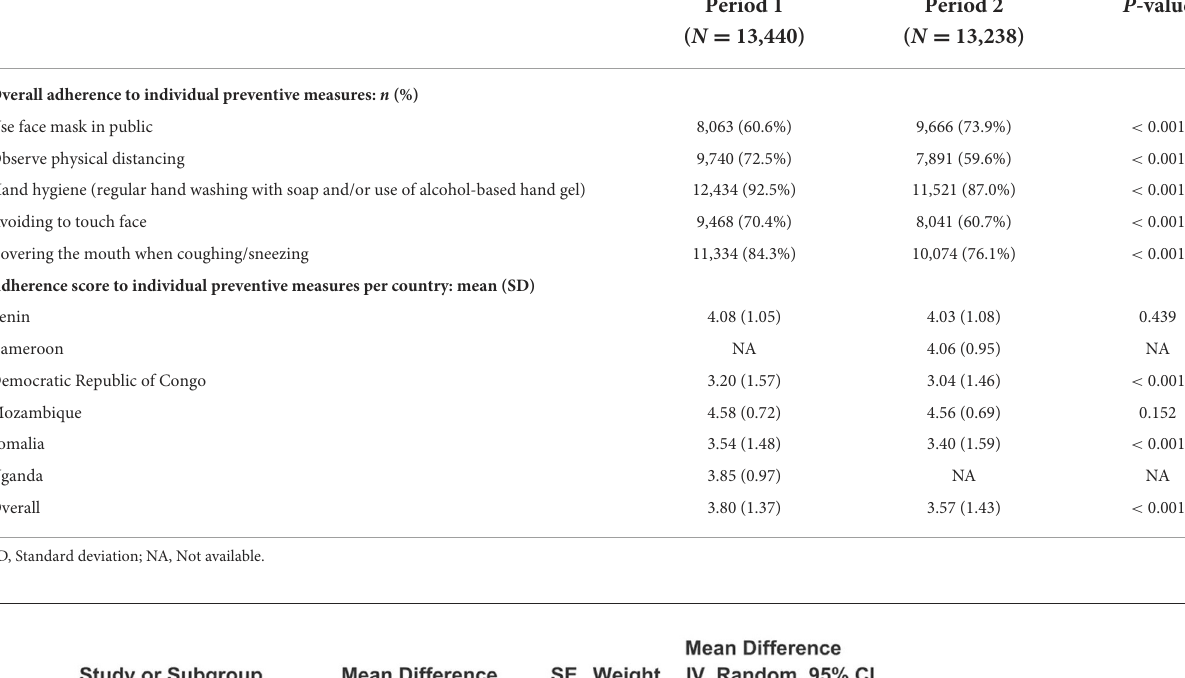
TABLE 2 Adherence to preventive measures during the study periods.